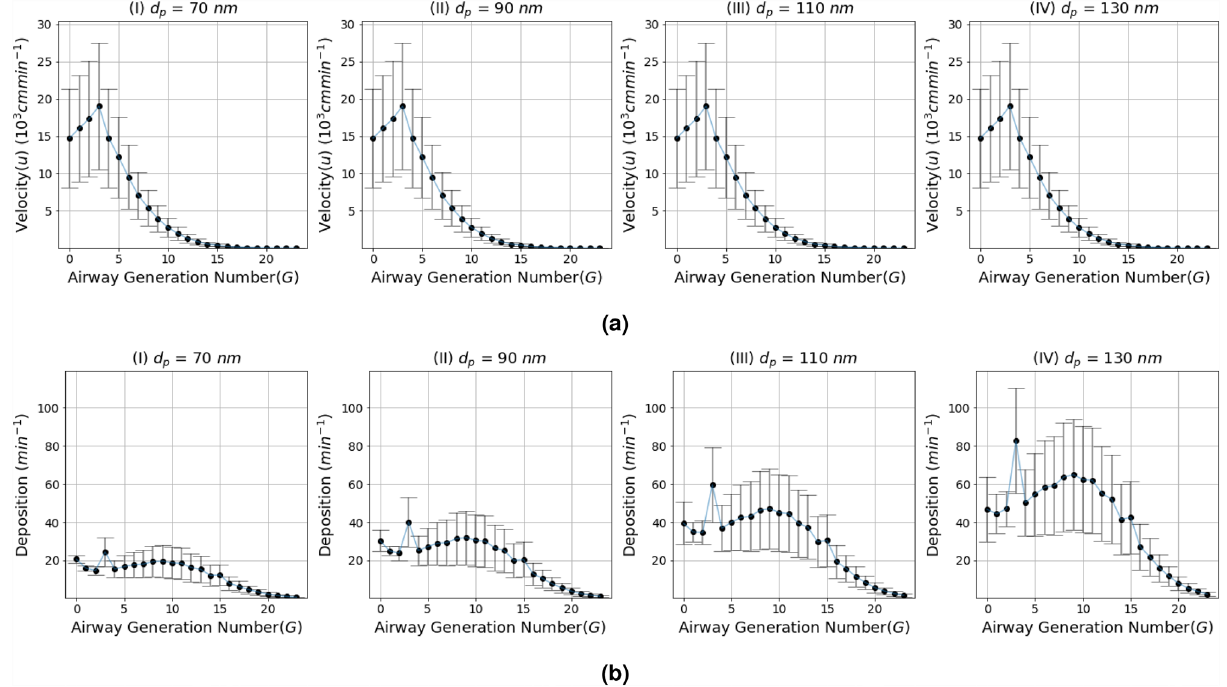
Figure 3. The impact of the virus particle diameter d p on the airflow velocity V and particle deposition rate k ; ( a ) airflow velocity V and ( b ) deposition rate k with respect to variations in the diameter of the virus particle d p in the 70–130 µ m , ( Q 0 varies in the rage 15–60 lmin −1 ).